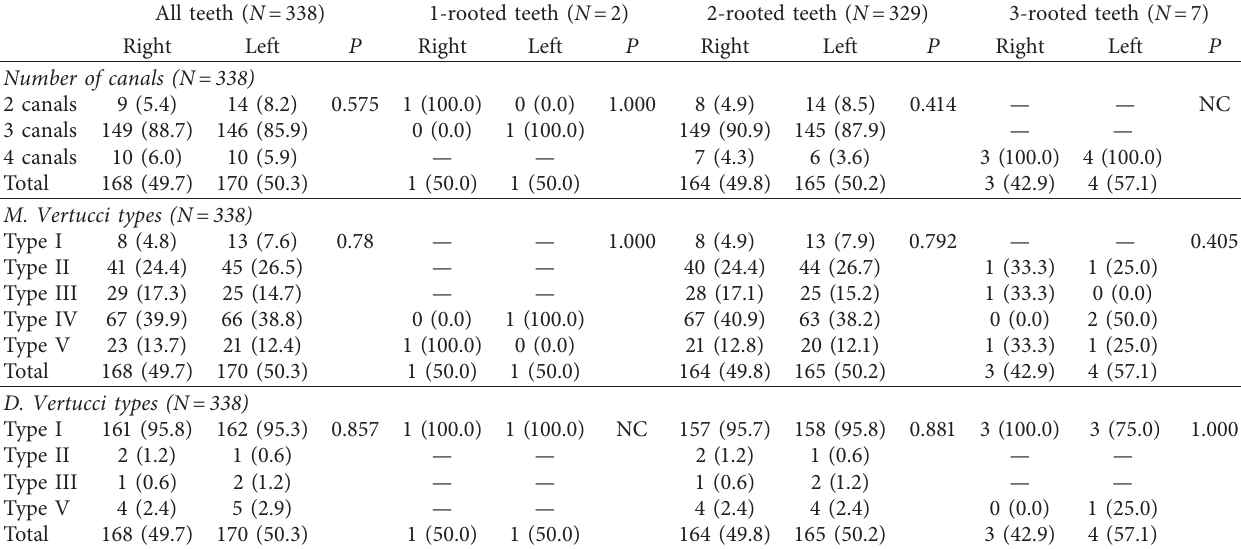
Table 4: Comparison amongst right and left edges among mandibular 2 nd molars N (%). All teeth ( N �